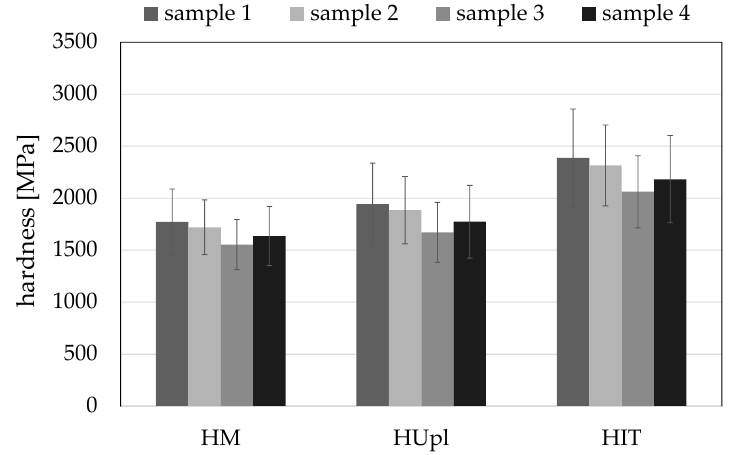
Figure 9. Arithmetic mean of hardness descriptors (25 measurements each) of four different micro samples and their standard deviations.